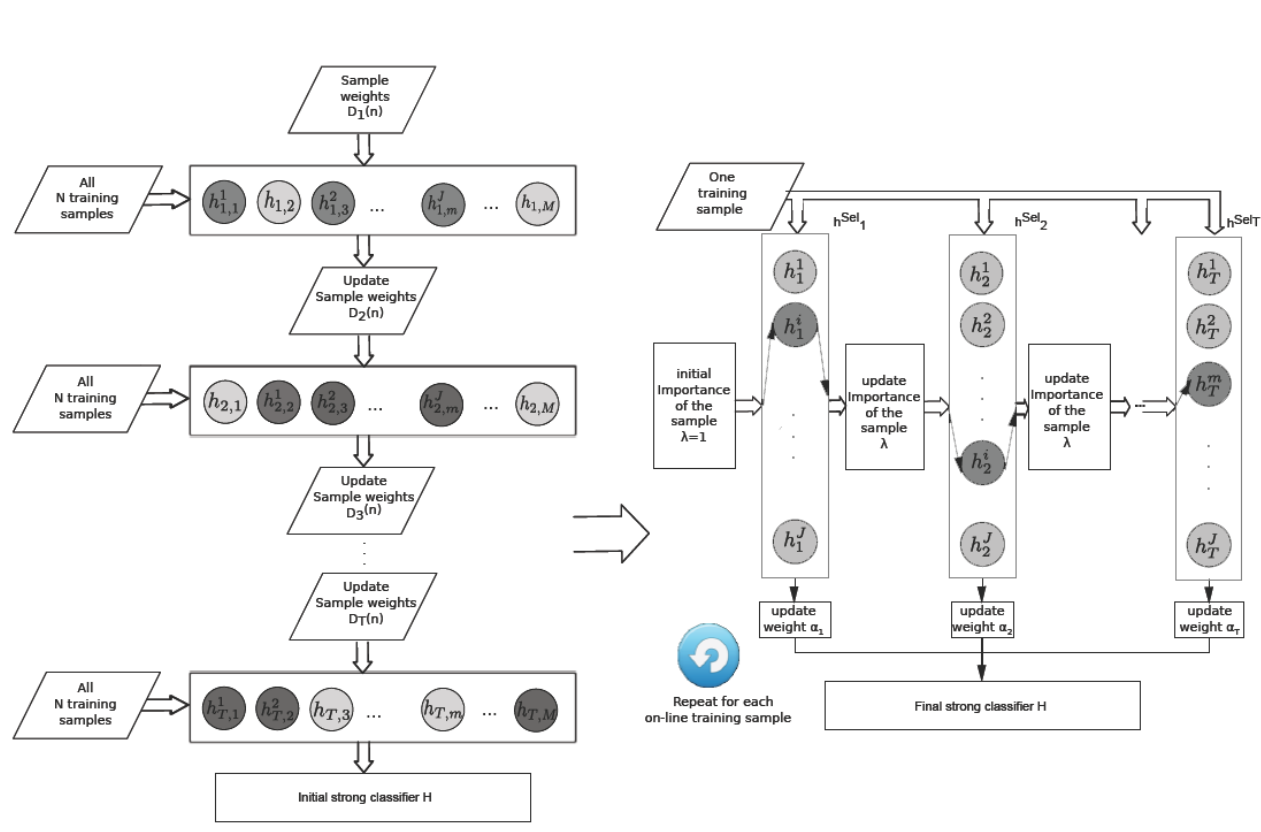
Figure 2 . This is a linking off-line and on-line learning: the off-line boosting for feature selection algorithm has to be adapted to select a set of J weak classifiers within each boosting